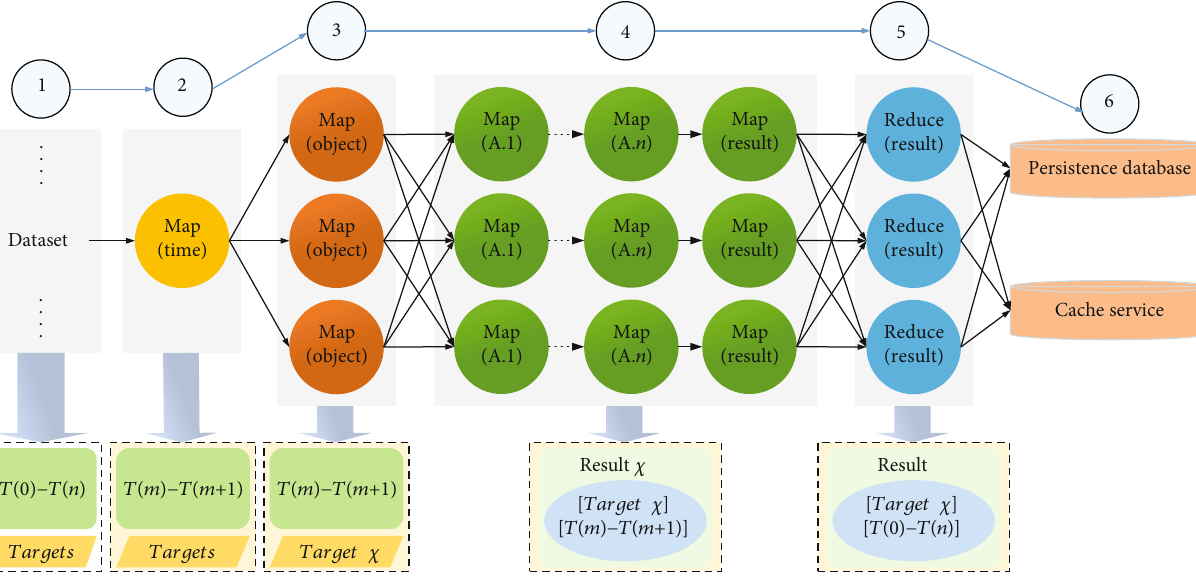
Figure 8: Data processing model and execution fl ow. In this model, the format of the dataset generated in each step is indicated in the dotted box. The time range T ð 0 Þ – T ð n Þ is divided equally into n parts, where m = 0 , 1, 2, … , n ‐ 1 . Target x is a subset of targets in the